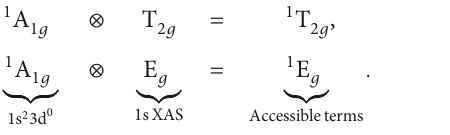
3) re fl ecting the orbital